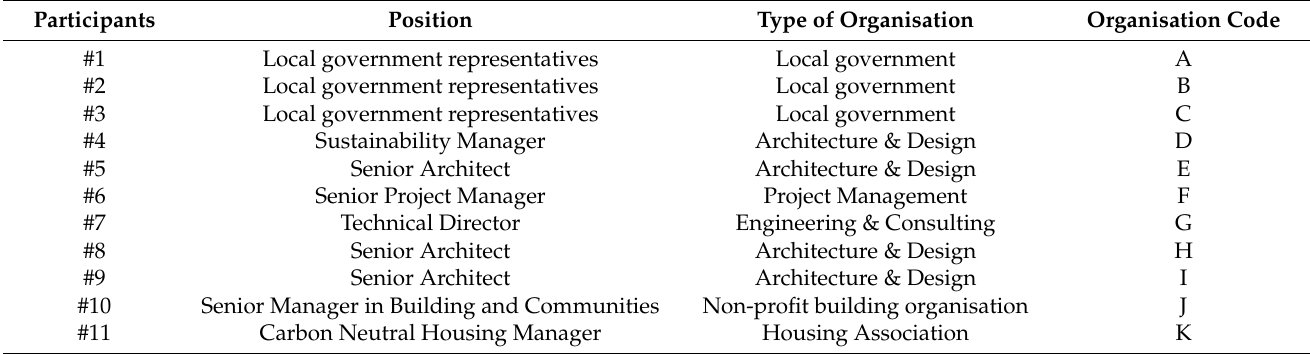
Table 1. Participants’